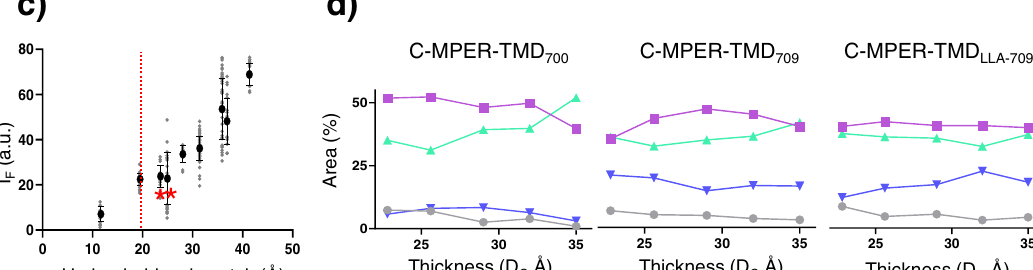
Fig. 4 10E8 epitope accessibility in C-MPER helices reconstituted in lipid bilayers of different thicknesses. a Models for 10E8 epitope exposure upon increasing the length of the membrane-spanning scaffold or the bilayer thickness. The C-MPER and the TMD are colored in purple and gray respectively. The extra turn in C-MPER-TMD LLA-709 is depicted in red. b Binding of Fab 10E8 to C-MPER helices as a function of the headgroup-to-headgroup distance (D HH ) parameter. c Binding extents as a function of the hydrophobic mismatch calculated as a function of the helix length and hydrocarbon core thickness (D C ). The red line starts at 19.5Å, i.e., the distance covered by the helicalC-MPER epitope. d Effect of thelipid bilayer thickness on the conformation adopted by C-MPER- TMD helices reconstituted in lipid bilayers. The evolution of the different structural components (percentage of IR amide-I band area, see Fig. S5) are displayed as a function of the D C parameter estimated by Gallová et al. 55 for the series of monounsaturated PCs. Symbols and lines colored as follows: Purple: 1655cm − 1 ( α -helix); Green: 1642cm − 1 (helix-helix interactions/disordered); Blue: 1630cm − 1 (solvated helices); Gray: 1672cm − 1